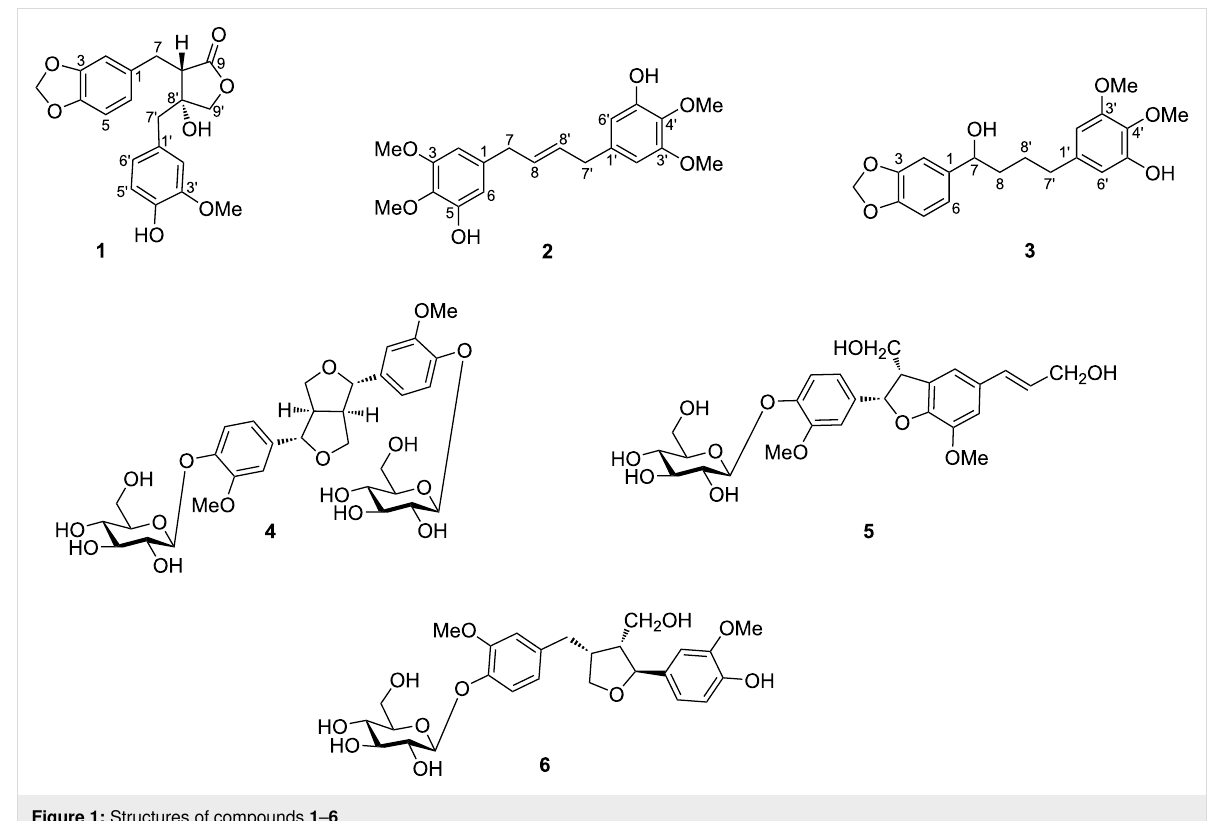
Figure 1: Structures of compounds 1 – 6